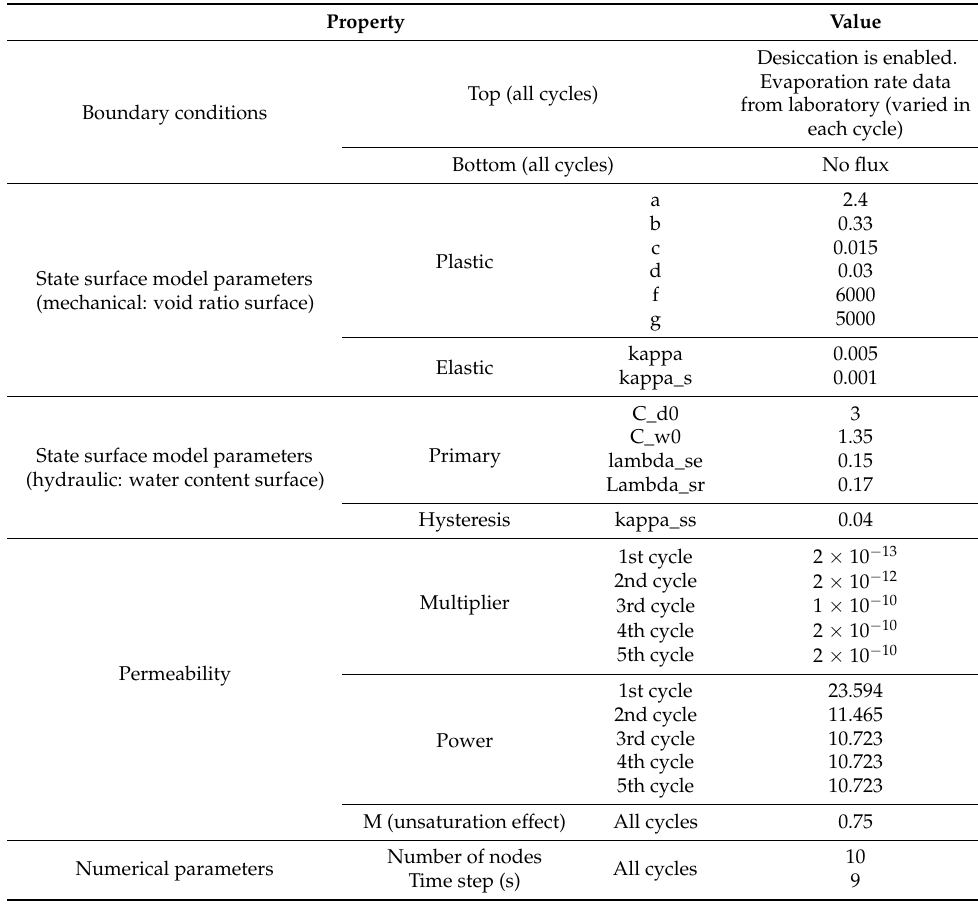
Table 3. Boundary conditions and summary of parameters for the UNSATCON